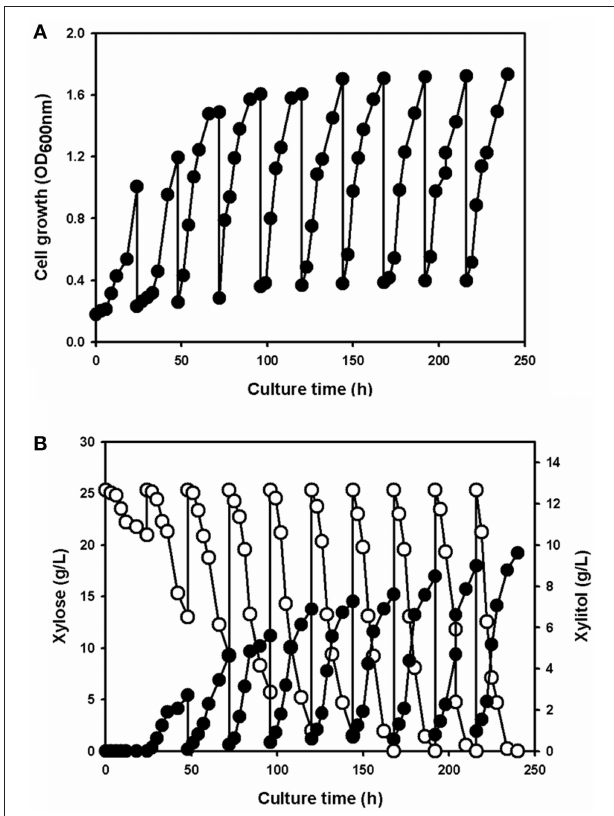
FIGURE 4 | The profiles of cell growth (A) , xylose consumption (open circle) and xylitol production (filled circle) (B) for Candida tropicalis strain CBS94 adapted in the batch culture containing the culture medium supplemented with xylose extract as the sole carbon source.